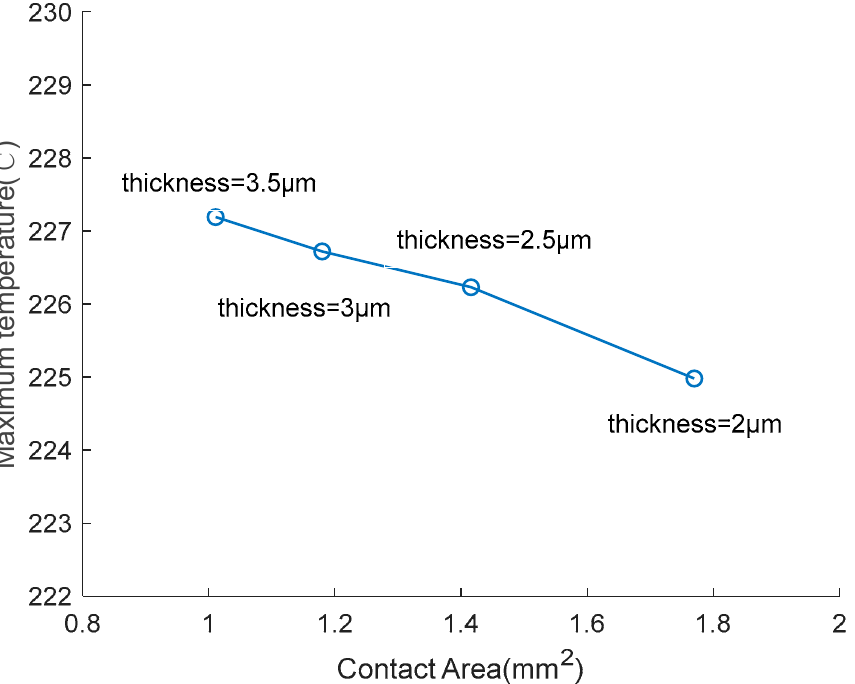
Figure 13. Temperature change of EC element under different contact areas.